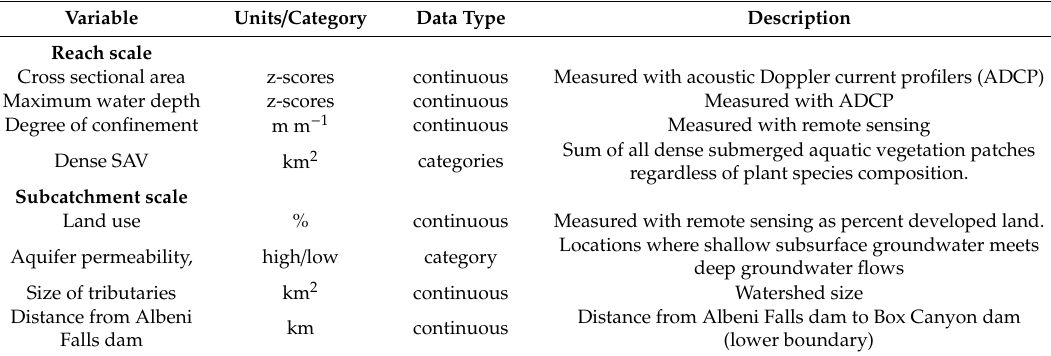
Table 2. Explanatory variables evaluated for associations with median radiant water temperature and the probability of occurrence of cool-water